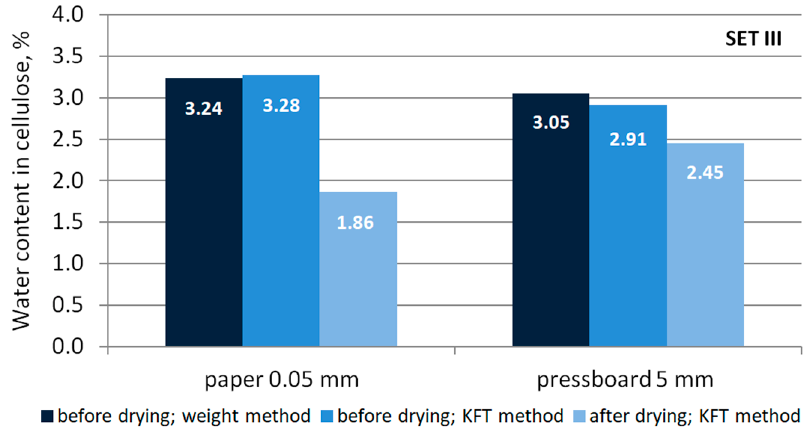
Figure 10. Water content in cellulose materials used in SET III before and after the drying process (70 ° C, 168 h).